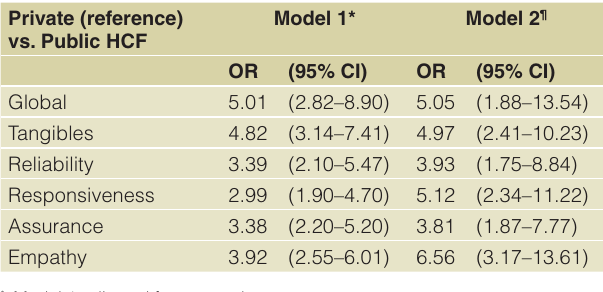
Table 5. Association of dissatisfaction, global and by domain, with type of health care facility. Private (reference) vs. Public